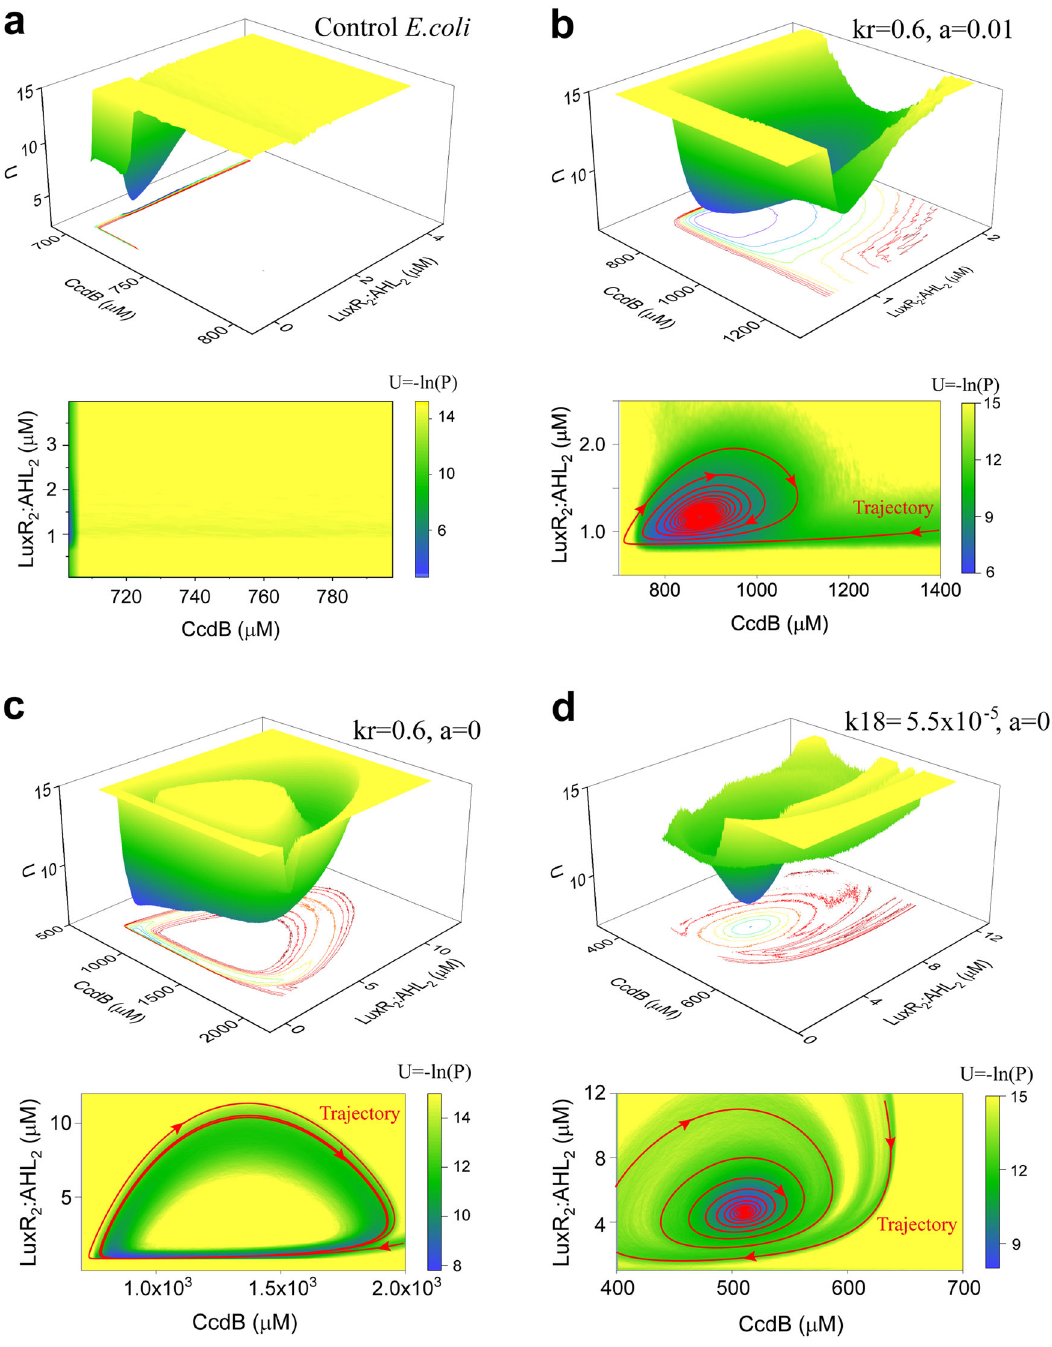
Fig. 7 Landscape changes when the oscillation-induction parameters and toxic coef fi cient are varied. The control E.coli system exhibits a monostable landscape ( a ). Variations of k r and the toxic coef fi cient ( a ) switch the system to the vortex-like pattern landscape ( b ), whereas the system presents the Mexican hat landscape after removing the effect of toxic factors ( c ). Variations of k 18 and a can also switch the system to the vortex-like pattern landscape ( d the stationary phase. Using the constructed model, dynamical behaviors of the key proteins, complexes and the promoter responding probabilities are systemically studied, which are dif fi cult to be explored in experiments at present. Compared with previous studies, several new insights are provided by this study on the system, such as how the components, i.e., IPTG, AHL permeability, and RBS ef fi ciency, mediate the bacterial density.